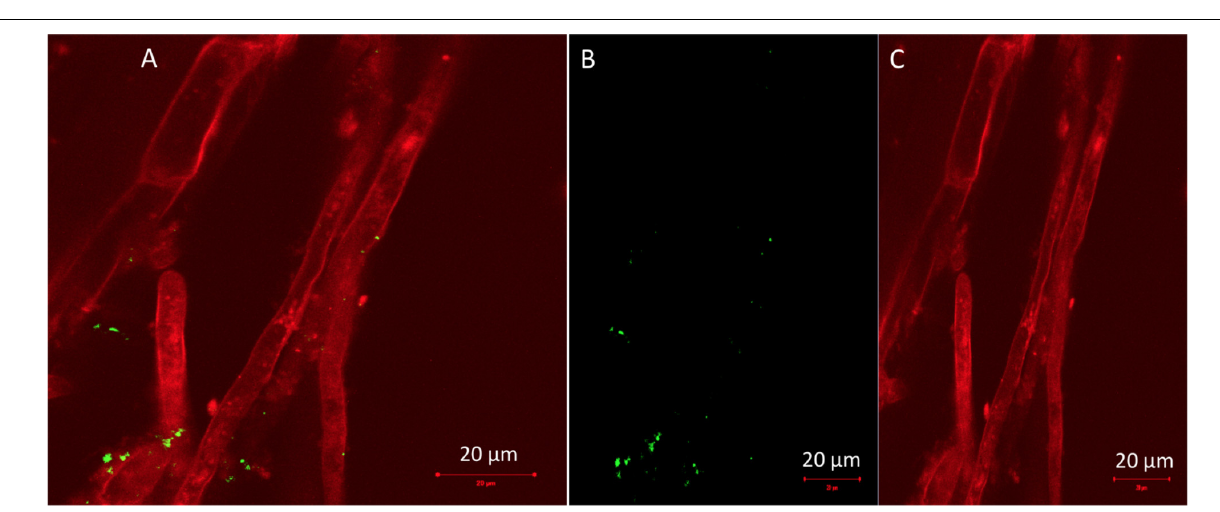
FIGURE 4 | Overview of the relative populations of leaf endophytes with respect to phylum and class under the different level of pollution.